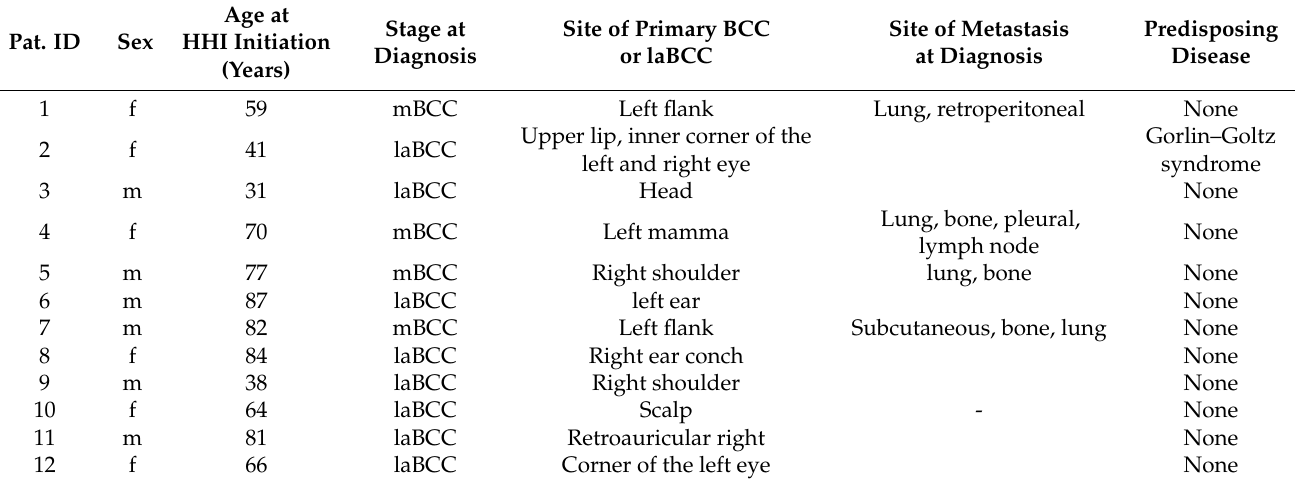
Table 1. Patient